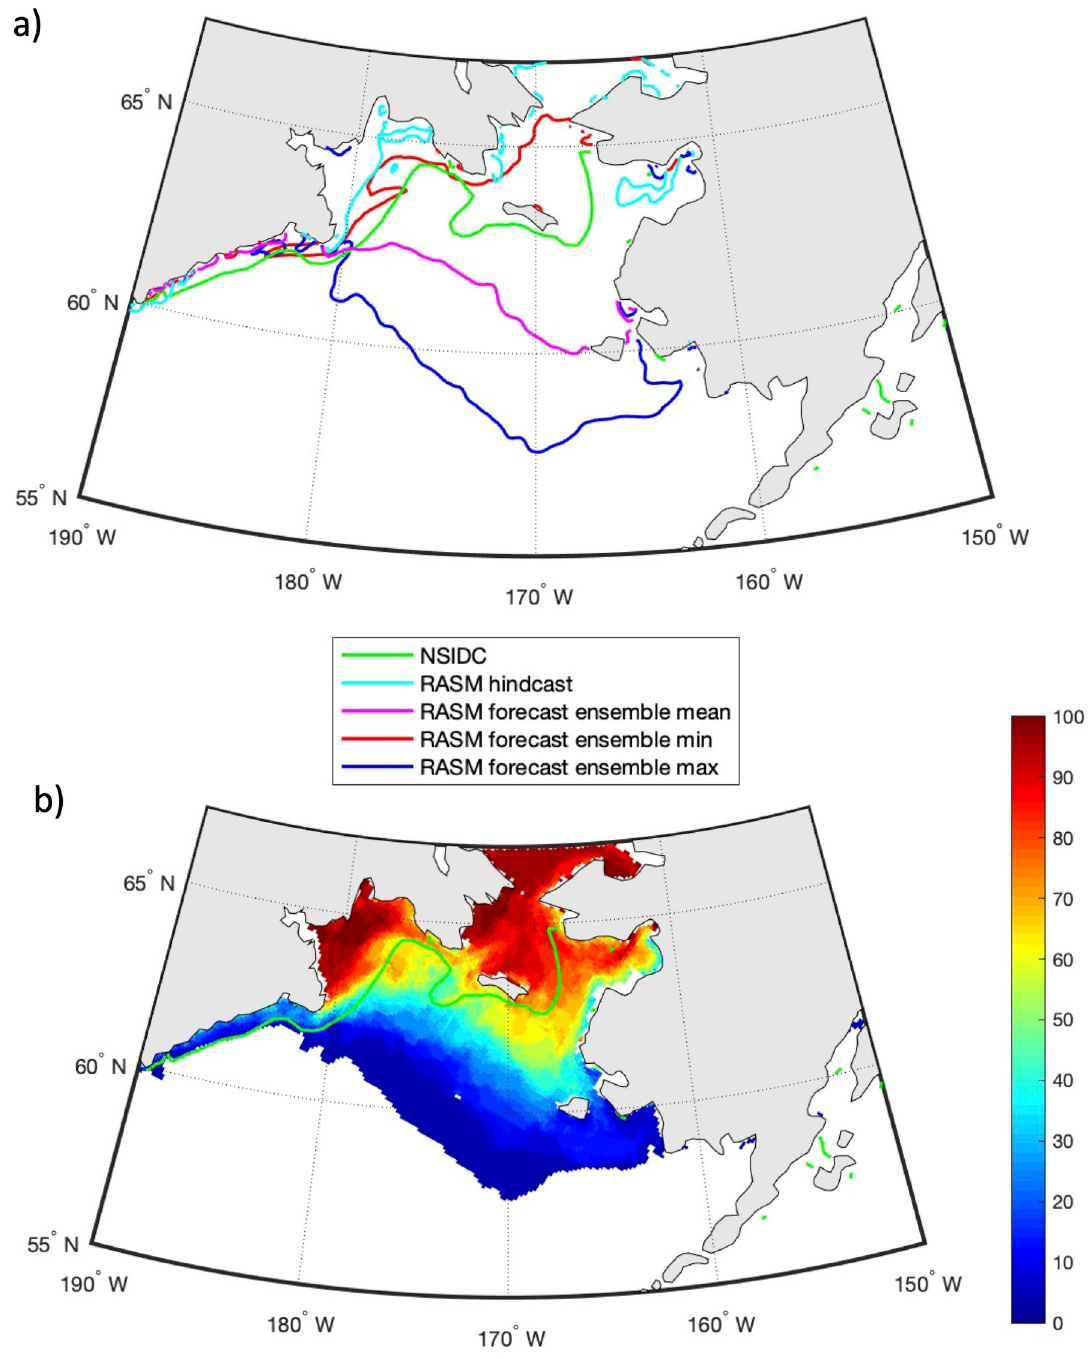
Fig 12. Predictions of sea ice extent and probability for April 15, 2019. (a) The RASM predicted ensemble mean (purple), maximum (blue) and minimum (red) sea ice extent on April 15, 2020, with all 31 individual member forecasts initialized on February 1, 2019. (b) The predicted probability of sea ice extent for April 15, 2019. The green line is the NSIDC observed sea ice extent [43] on April 15, 2019. The light blue line is the respective sea ice extent from the RASM hindcast. Figure created using Matlab (v. 2018a) from the authors’